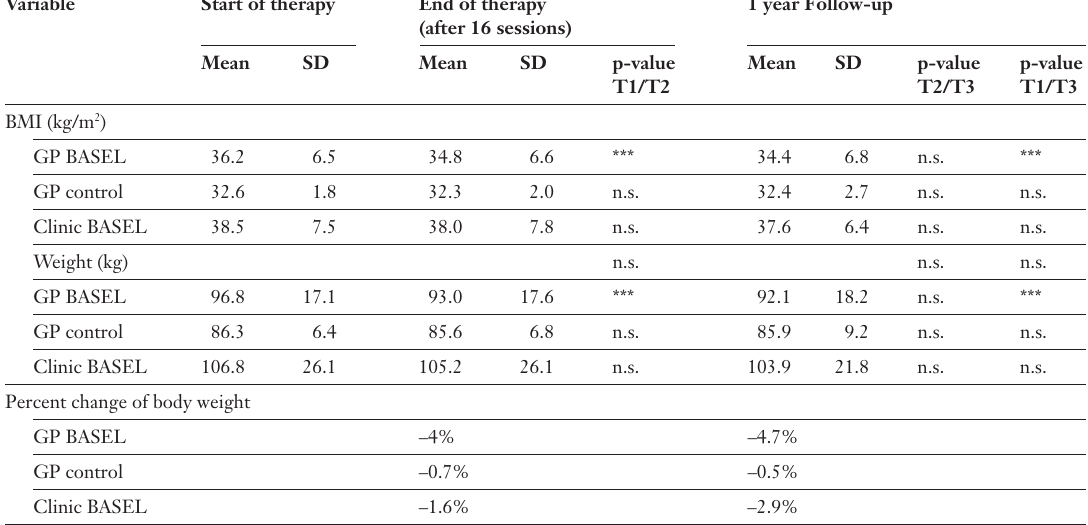
BMI, body weight and percent change of body